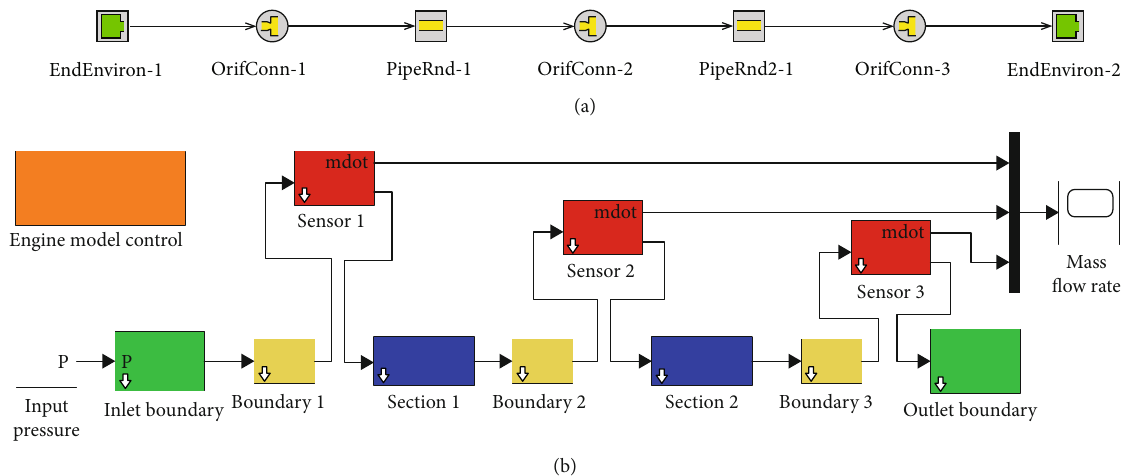
Figure 12: (a) GT-POWER and (b) Simulink block diagrams of the 1D fl ow